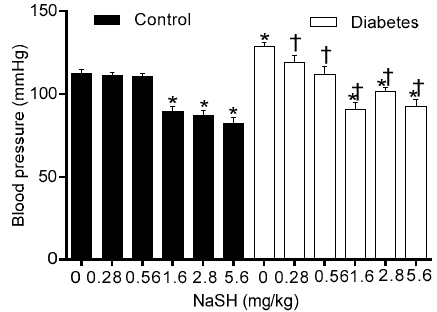
Figure 8. Effects of NaSH on blood pressure. Results are mean ± SEM (n = 9/group). * p < 0.05 compared to non-treated control rats, † p < 0.05 compared to non-treated diabetic rats.